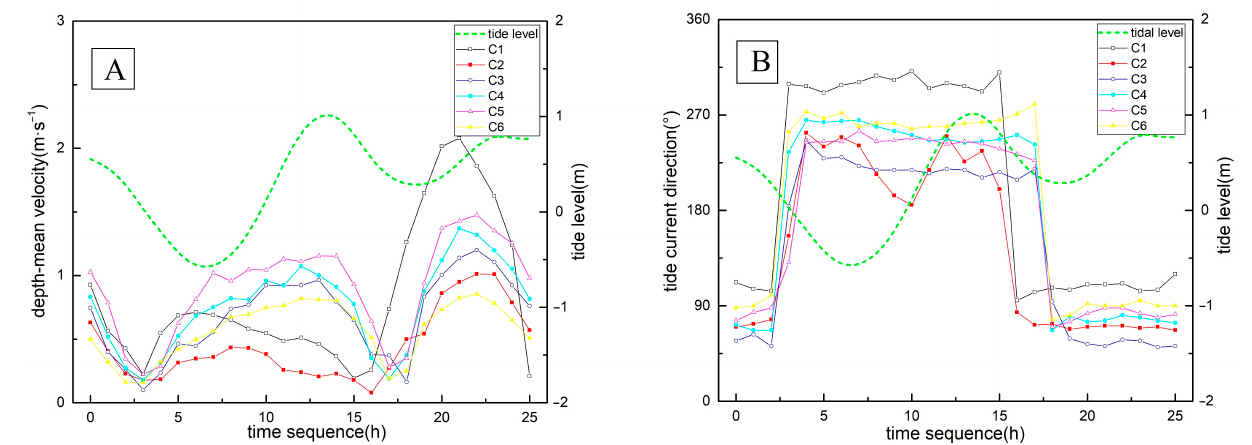
Figure 5. Time series of the tidal current at the six observation stations during spring tide. The green line represents the tidal level. ( A ) depth-mean velocity curve during one tidal period. ( B ) tidal current direction curve during one tidal period.